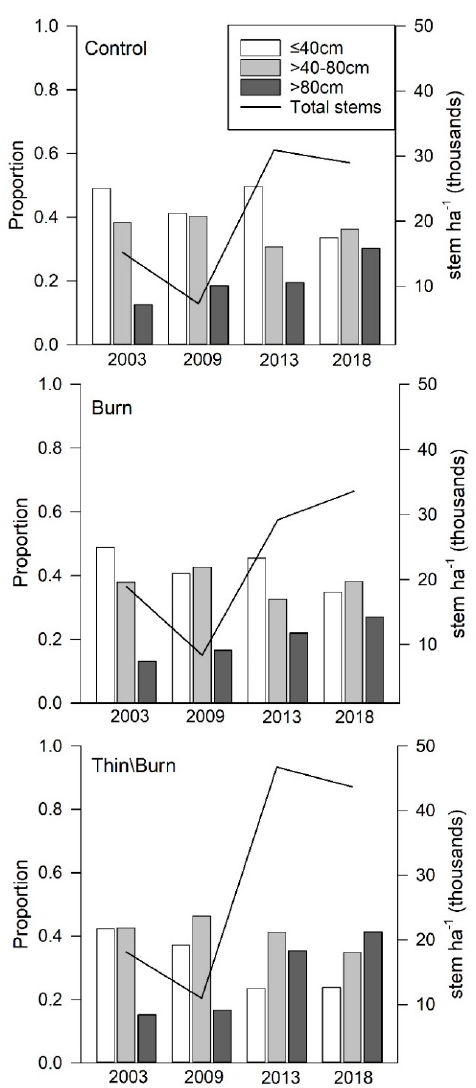
Figure 6. Proportion (bars and left y -axis) of the total stem density (line and right y -axis) of shrubs within three height classes in 2003 (pretreatment) and three post-treatment measurement years (2009, 2013, 2018). Each panel represent a treatment type ( n = 4). Table 2. Average density and frequency of the most common midstory species in 2003 (pretreatment) and 2018 (10 post-treatment) by treatment. N = 4; p ≤ 0.05. Treatment differences for density (within year) are indicated by letters (a, b for 2003 and x, y, z for 2018). Pretreatment (2003) and 10 post- treatment (2018) species density differences within treatments are indicated by bold text. Density (Stems/Trees ha − 1 ) Frequency (Proportion of Plots)